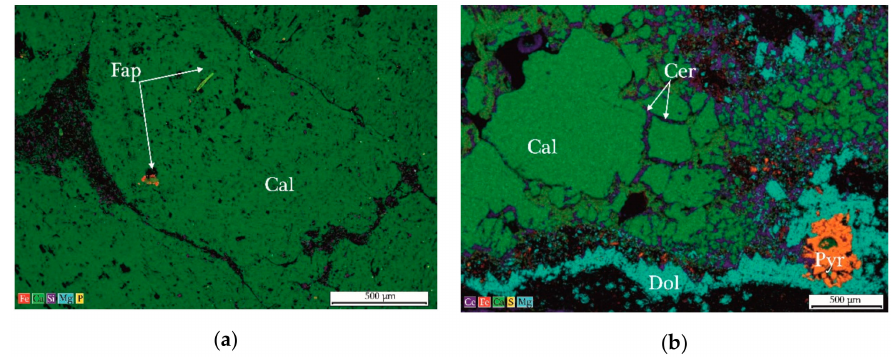
Figure 4. Elemental maps of FeK α , CaK α , SiK α , MgK α , PK α , SK α , CeK α : ( a ) sample 6-1-2 (Syas River in Kolchanovo); ( b ) sample 4-6 (Popovka River). Cal—calcite, Dol—dolomite, Pyr—pyrite,